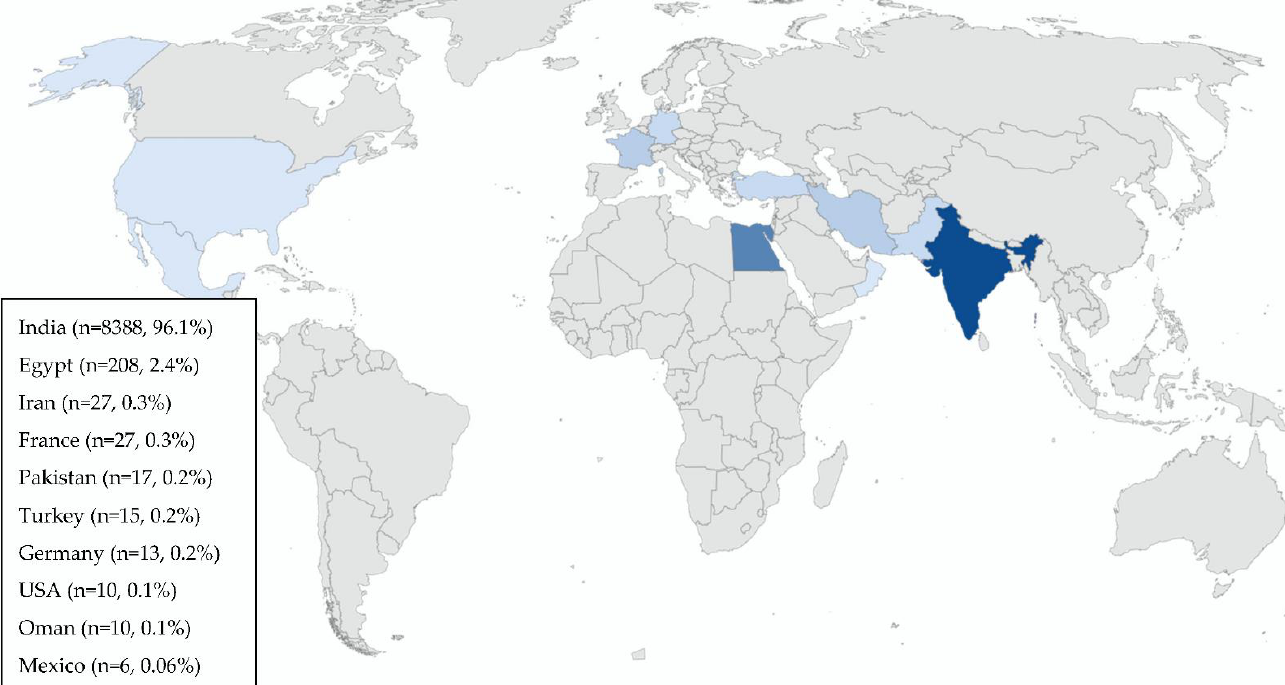
Table 2. Incidence of CAM among hospitalized COVID-19 patients, type of infection, invasive or non-invasive mechanical ventilation, risk factors and all-cause mortality .